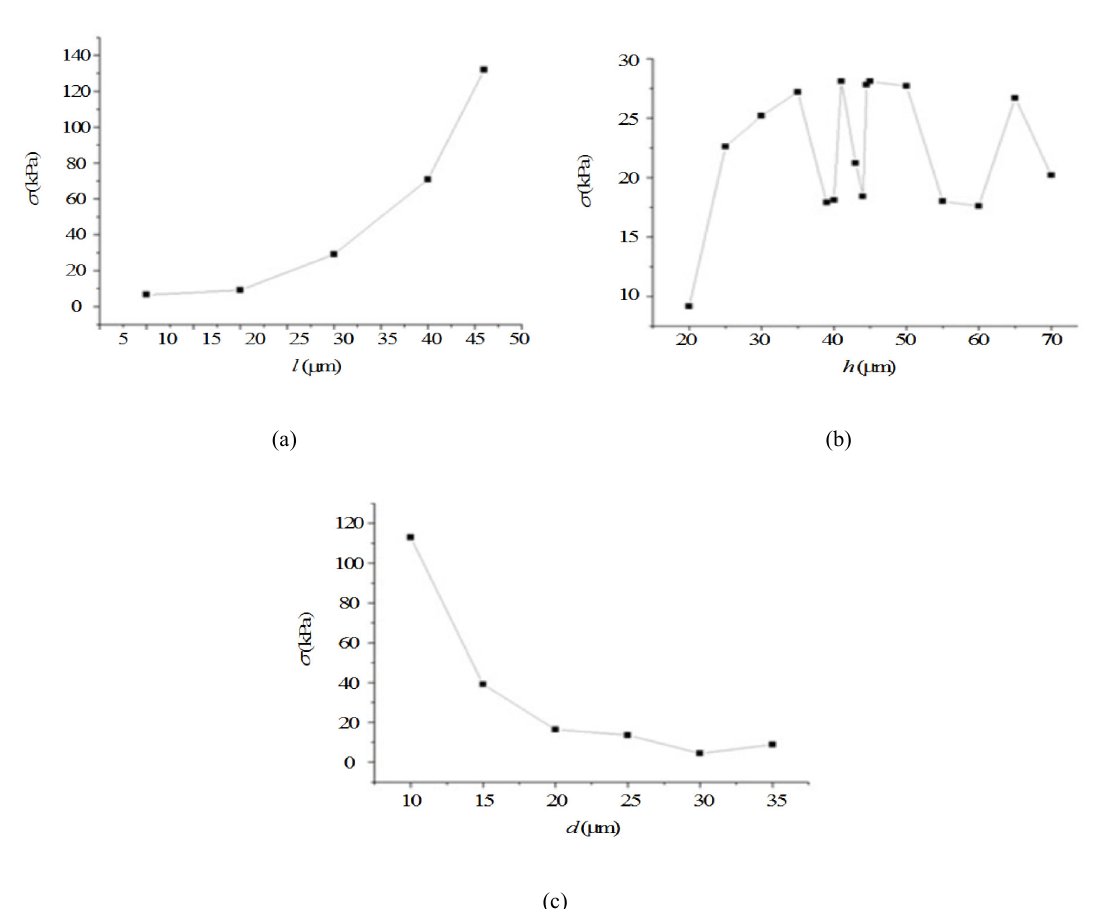
Fig. 9 Strain difference changes versus (a) length l (height h = 20 µ m and distance d = 31.25 µ m), (b) height h ( l = 20 µ m and d = 31.25 µ m) of rectangular holes, and (c) distance d ( l = 20 µ m and h = 20 µ m) between the centers of the core and holes at the temperature of 80 ℃